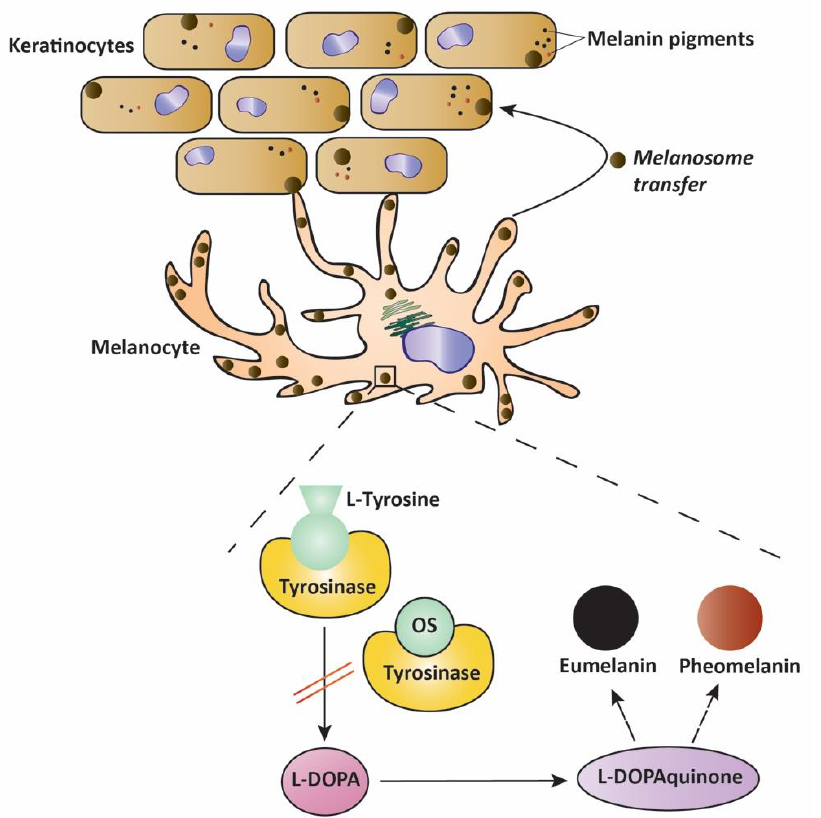
Figure 6. Origanum syriacum exhibits antimelanogenic properties by blocking melanogenesis. Origanum syriacum reduced the production of melanin by blocking the activity of the tyrosinase enzyme in a competitive inhibition model. OS: Origanum syriacum.